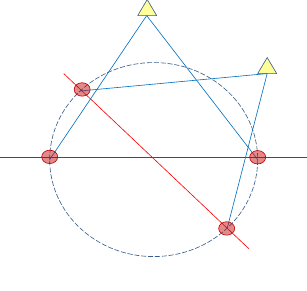
Figure 5.b. Two cameras rotate around a certain baseline’s center. Optical parallaxes are